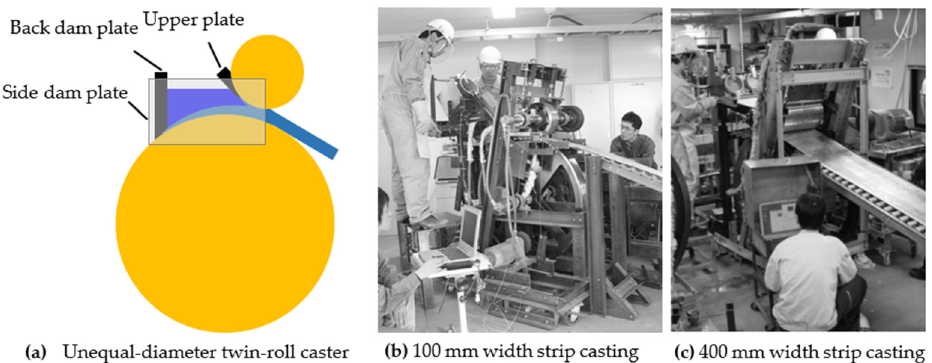
Figure 16. Schematic illustration of an unequal-diameter twin roll caster and photograph of casting procedure. ( b ) D: 250 mm (upper) and 1000 mm (lower), W: 100 mm, V: 30 m/min, ( c ) D: 300 mm (upper) and 1000 mm (lower), W 400 mm, V: 30 m/min. D: roll diameter, W: roll width, V: roll speed.